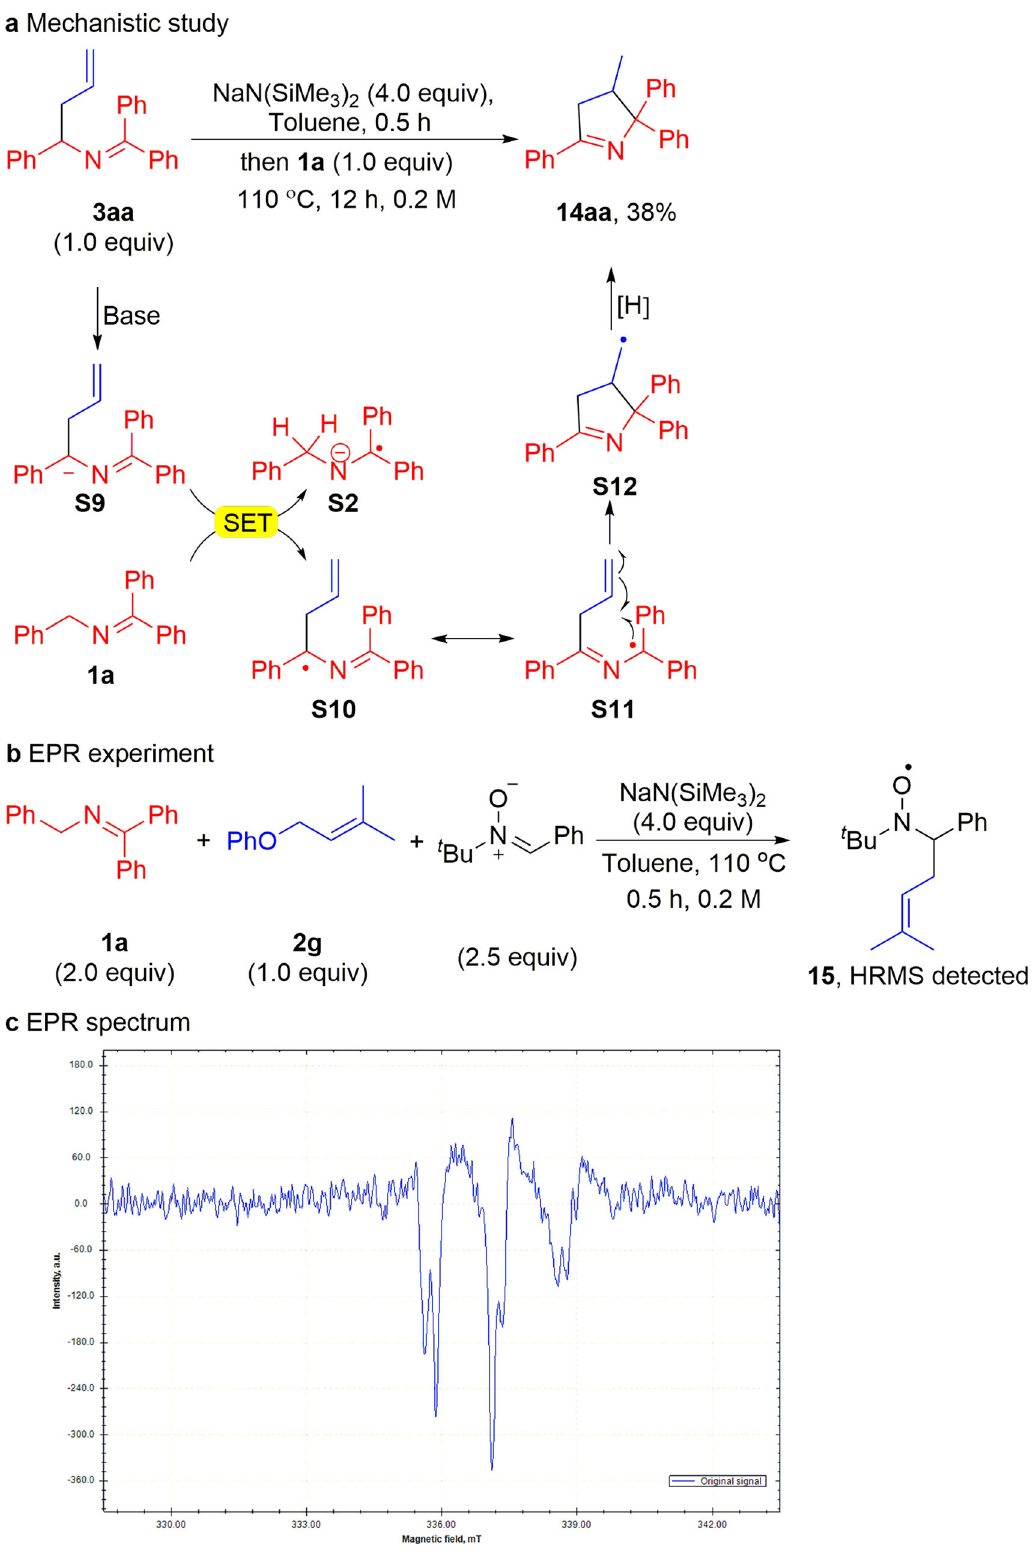
Fig. 9 Mechanistic and EPR studies. a Mechanistic experiment with allylation product 3aa . b EPR experimental conditions. c X-band EPR spectrum of the PBN-trapped carbon-centered radical ( T = 298 K; microwave frequency: 9.462390GHz; power: 0.2 mW; center fi eld: 336.00 mT; sweep width: 15.0 mT; modulation frequency, 100 kHz; modulation amplitude, 100 μ T). SET, single electron transfer. EPR, electron paramagnetic